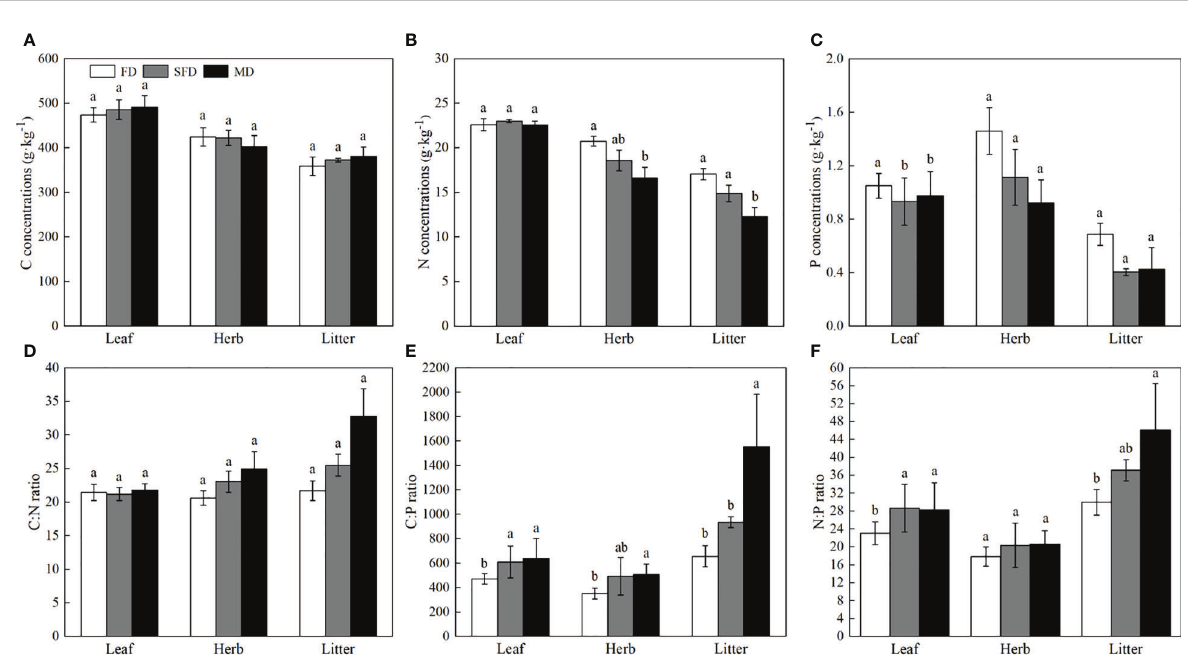
FIGURE 1 C, N, and P concentrations (A – C) and stoichiometry (D – F) in different components. Sophora moorcroftiana shrub under different sandy dune types. Different lowercase letters indicate signi fi cant difference under different sandy dune types based on analysis of variance and least signi fi cant difference tests (P< 0.05). FD, fi xed dune; SFD, semi fi xed dune; MD, moving dune; Herb, understorey herb